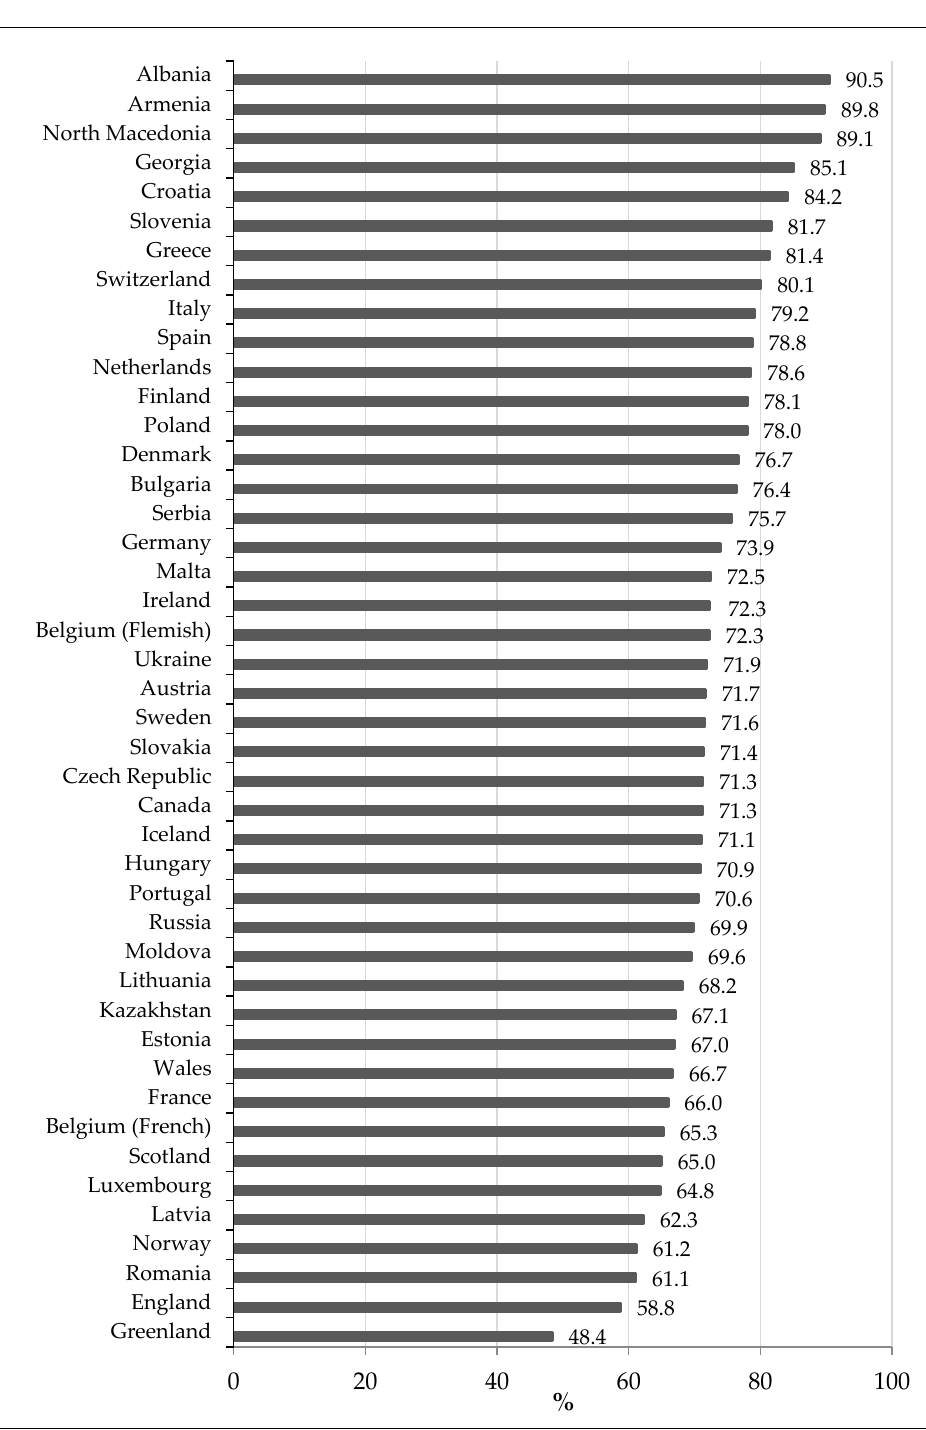
Figure 3. Proportion of intact families by HBSC countries in 2018.